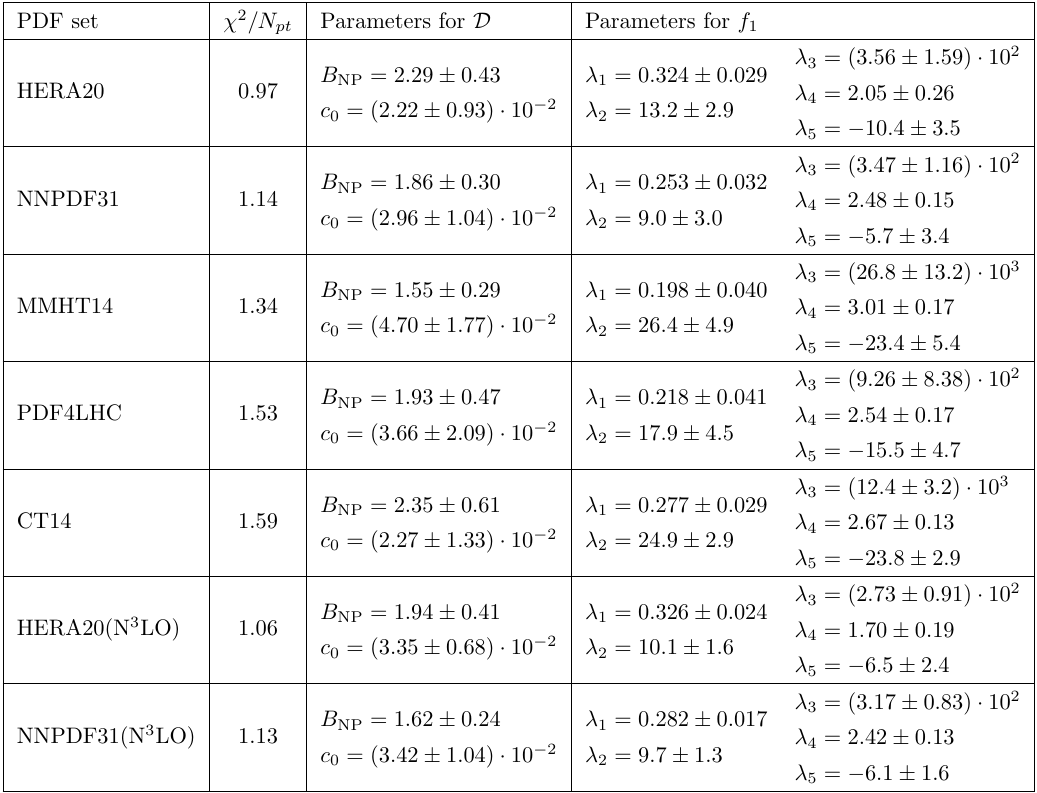
Table 5 . Values of (cid:31) 2 and NP parameters obtained in the (cid:12)t of DY set of the data with di(cid:11)erent PDF inputs. Each set of PDF provide the corresponding value of (cid:11) s ( M Z